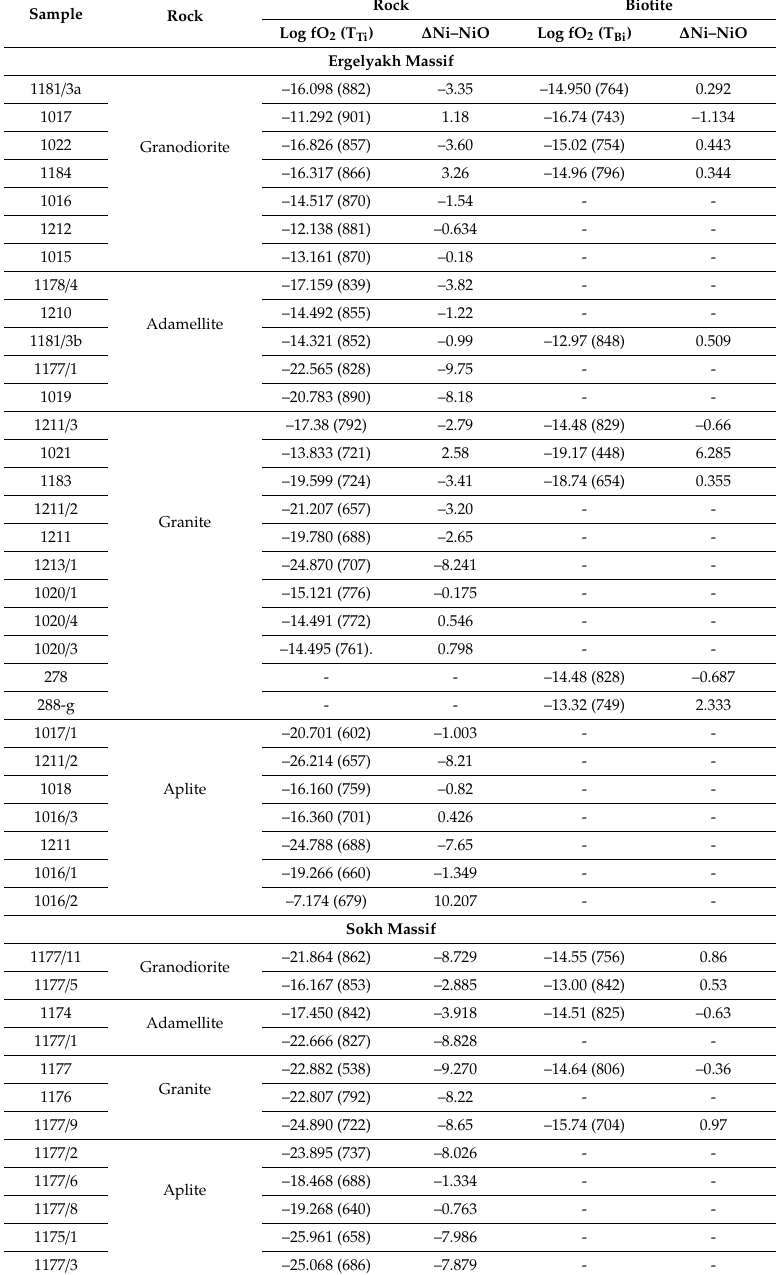
Table 13. fO 2 values for Ergelyakh and Sokh massif